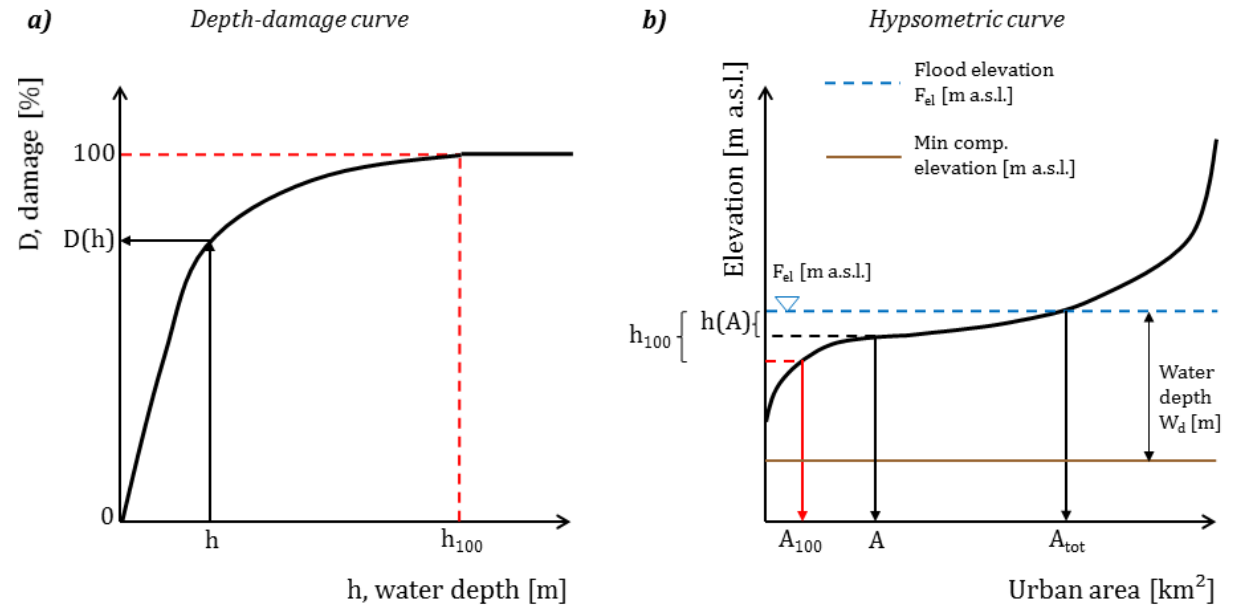
Figure 1. Schematic representation of the combination of (a) Depth-damage and (b) Hypsometric Vulnerability Curves for estimating potential flood damages in urban